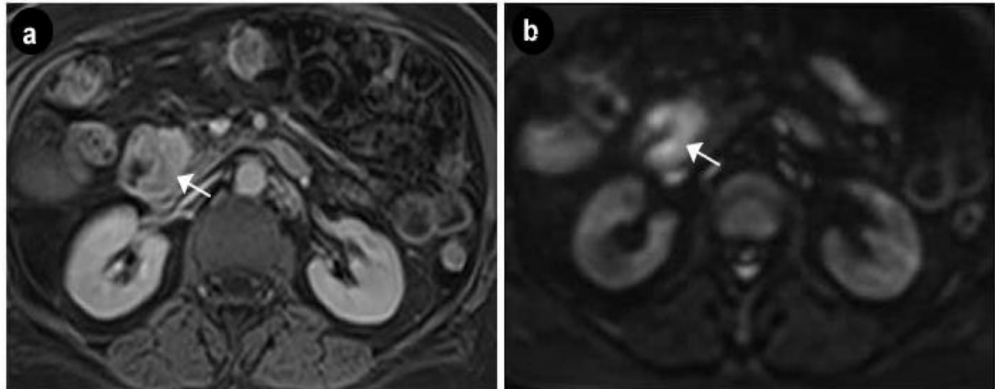
Figure 5. Axial MRI exam—duodenal tumor. ( a ) Gadolinium enhanced T1w image showing an hyperintense lesion in the arterial phase suggestive of the neuroendocrine etiology (arrow). ( b ) Di ff usion Weighted Imaging (DWI) showing an hyperintense lesion with intense di ff usion restriction (arrow).